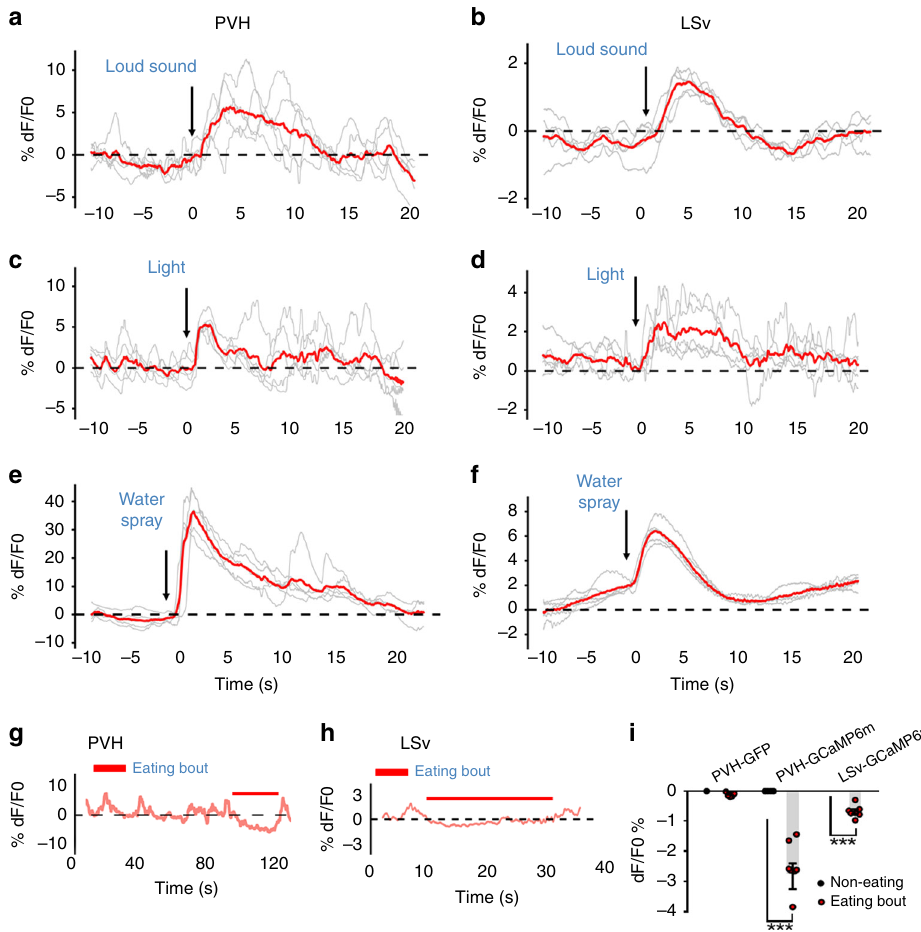
Fig. 7 In vivo Ca2 + fi ber photometry measurements of PVH and LSv neuron activity during stress and feeding. Sim1-Cre a , c , e , and g and Vgat-Cre male mice ( b , d , f , and h ) with AAV-Flex-GCaMP6m delivery to the PVH ( a , c , e , and g ) or LSv ( b , d , f , and h ) were implanted with fi beroptics targeting the PVH or LSv for fi ber photometry monitoring the in vivo activity of PVH and LSv neurons in freely moving mice. A loud sound ( a and b ), a brief light exposure in dark ( c and d ), water spray toward head ( e and f ) were associated with rapid activation of PVH ( a , c , e , and g ) and LSv ( b , d , f , and h ) neurons. In contrast, the activity of PVH g and LSv h neurons was highly associated with eating bouts; and i summary data showing comparison in activity changes indicated by averaged means in Ca2 + imaging between periods with feeding bouts and the testing period in the groups indicated. PVH-GFP: recording from PVH neurons expressing GFP mediated by Sim1-Cre ; PVH-GCaMP6m: recording from PVH neurons expressing GCaMP6m mediated by Sim1-Cre , and LSv- GCaMP: recording from LSv neurons expressing GCaMP6m mediated by Vgat-Cre ( n = 8 – 10 each group). *** p < 0.001, two-way ANOVA tests, eating versus non-eating bouts. The red lines in a – f represent averaged means of traces from the indicated individual stressing